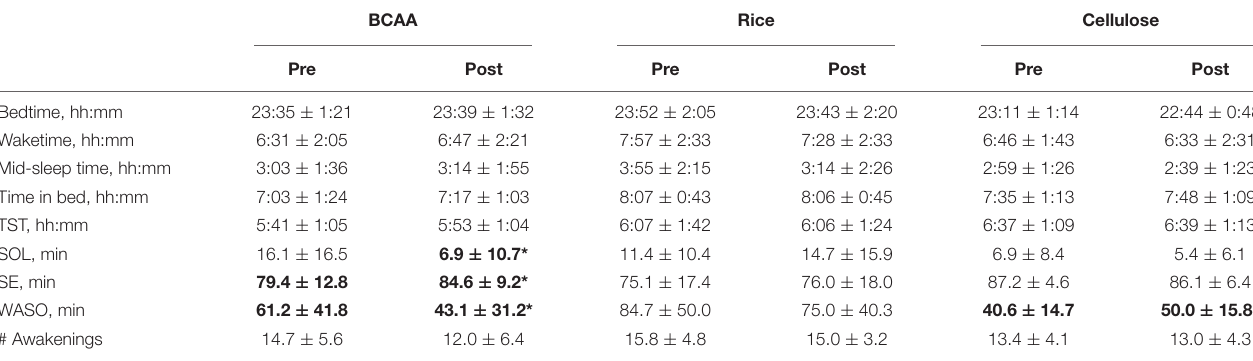
TABLE 2 | Actigraphy.